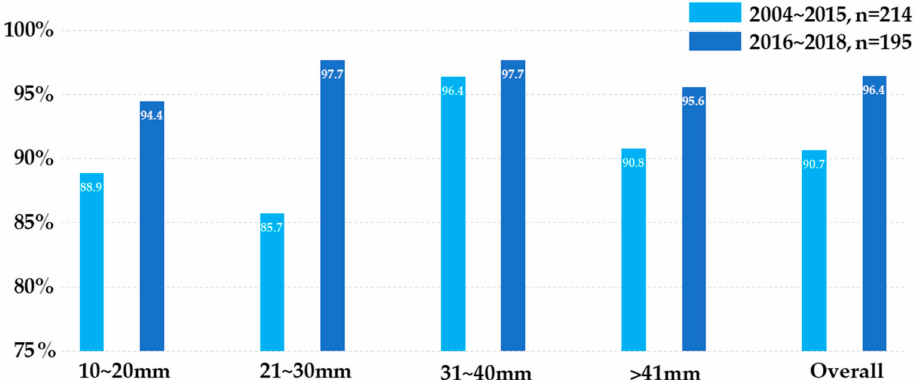
Figure 3. Diagnostic accuracy categorized by tumor size. The light blue bar represents cases performed between 2004 and 2015, while the dark blue represents cases after 2016. The diagnostic accuracy significantly improved after the learning curve period and with